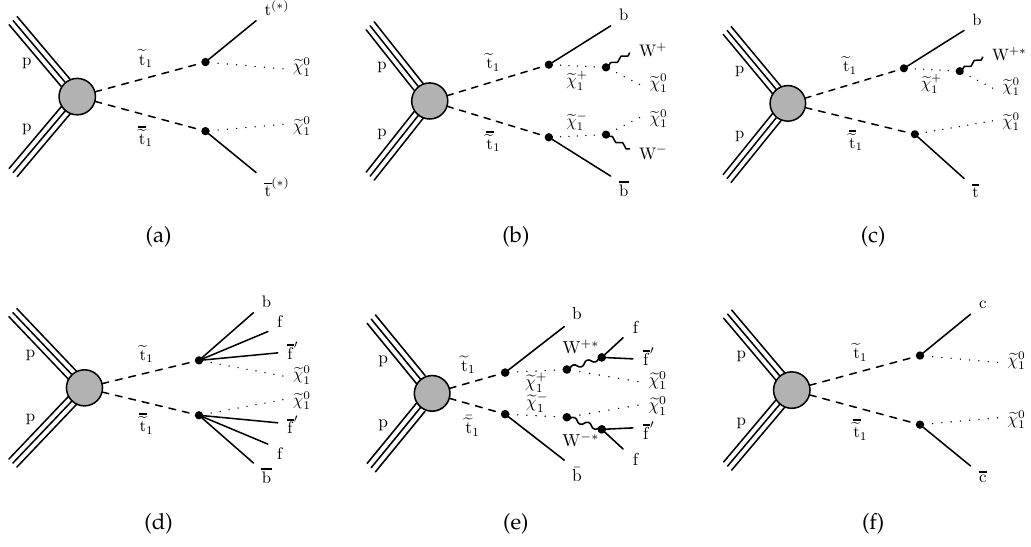
Figure 1 . Diagrams for the decay modes of pair-produced top squarks studied in this analysis. The decay cascades are denoted: (a) T2tt, (b) T2bW, (c) T2tb, (d) T2ttC, (e) T2bWC, and (f) T2cc. An asterisk indicates that the particle may be produced o(cid:11)-shell.